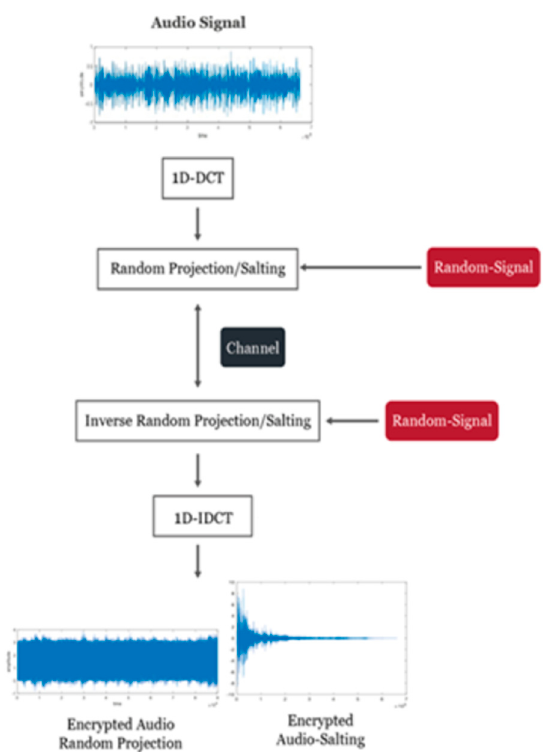
Figure 2. A 1D DWT fusion system for encryption with random projection and salting.